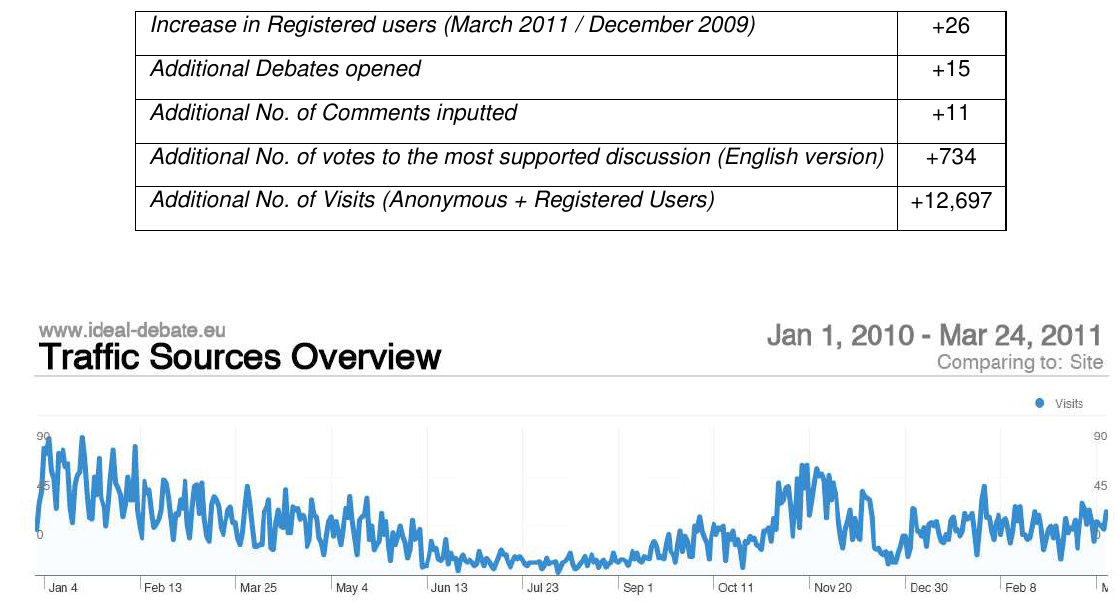
Table 3: SNP Indicators (January 2010 - March 2011)